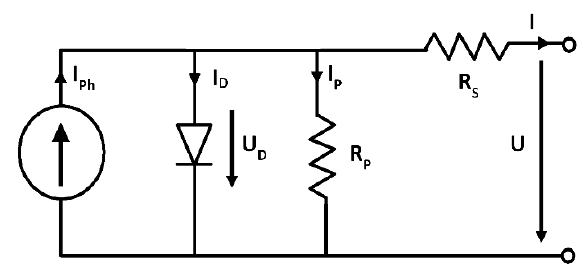
Figure 1. One-diode model of a photovoltaic (PV) cell.